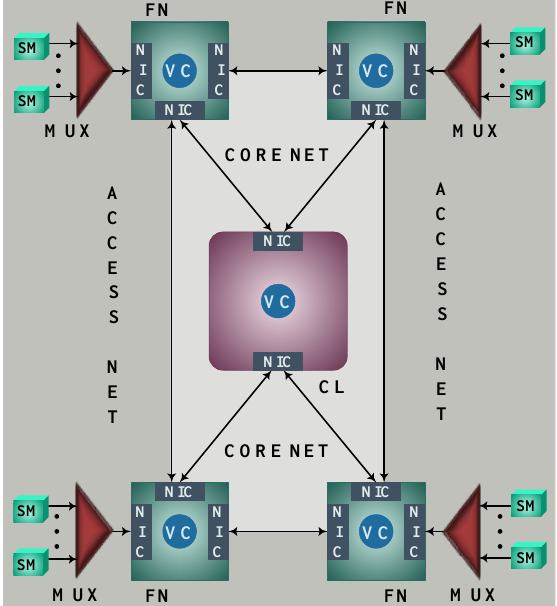
Figure 1. A sketch of the proposed SmartFog technological platform. Arrowed paths indicate data links. SM: = Smart-Meter; MUX: = Multiplexer; FN: = Fog Node; CL: = Cloud; VC: = Virtual Clone; NIC: = Network Interface